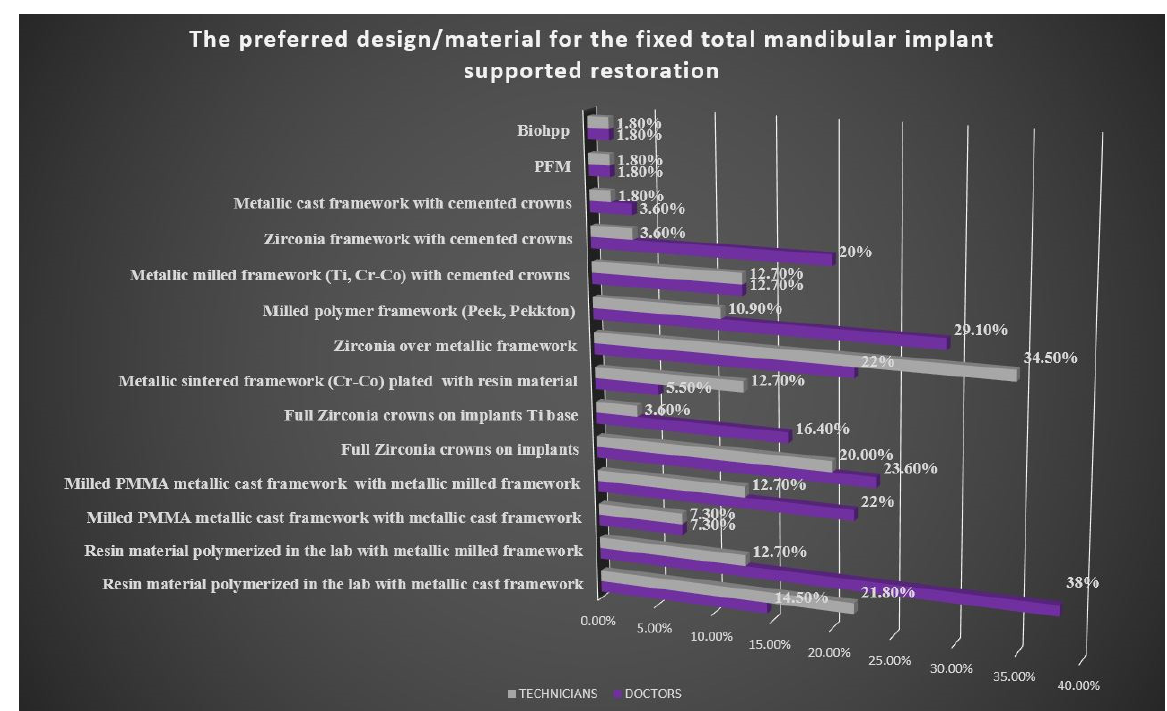
Figure 4. The preferred design/material for the fixed total mandibular implant supported restoration: doctors vs. technicians.